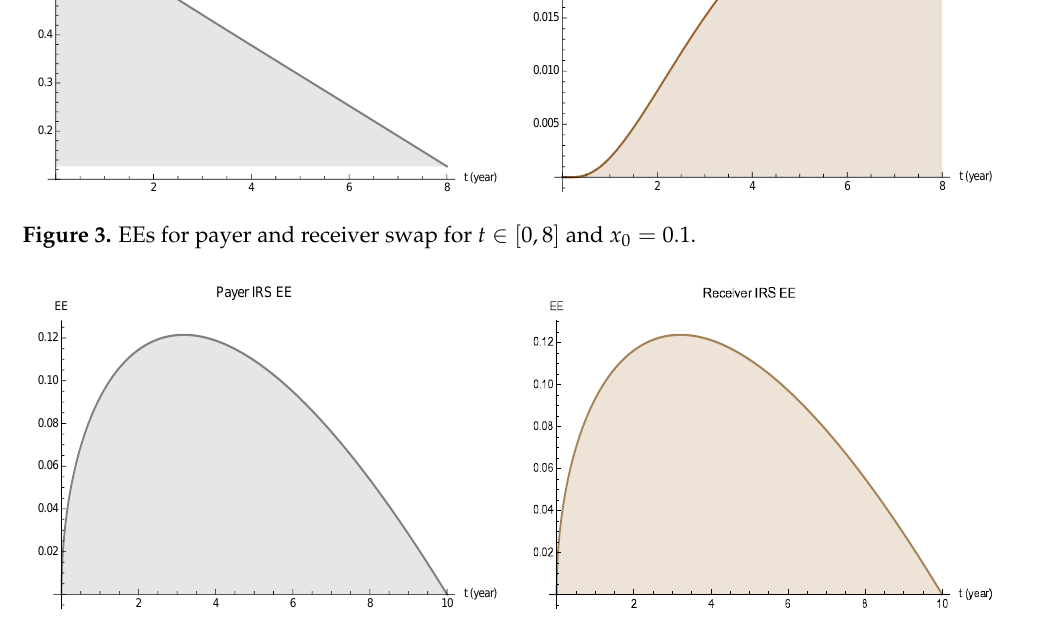
Figure 4. EEs for payer and receiver swap for t ∈ [ 0,10 ] and x 0 =